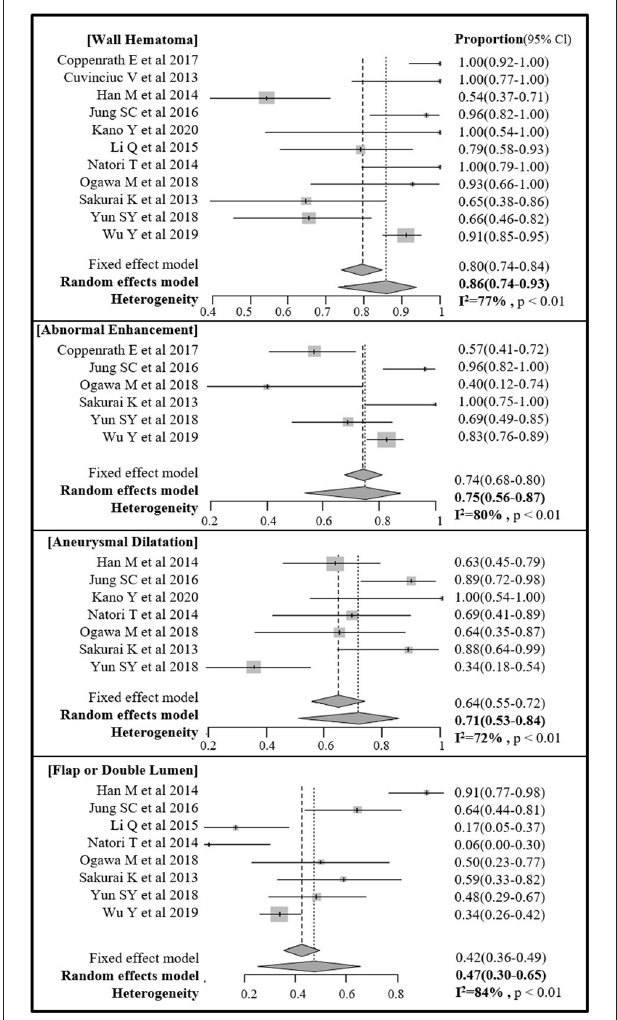
FIGURE 2 | Forest plot of pooled proportion of image findings of direct signs of craniocervical arterial dissection on magnetic resonance (MR) vessel wall